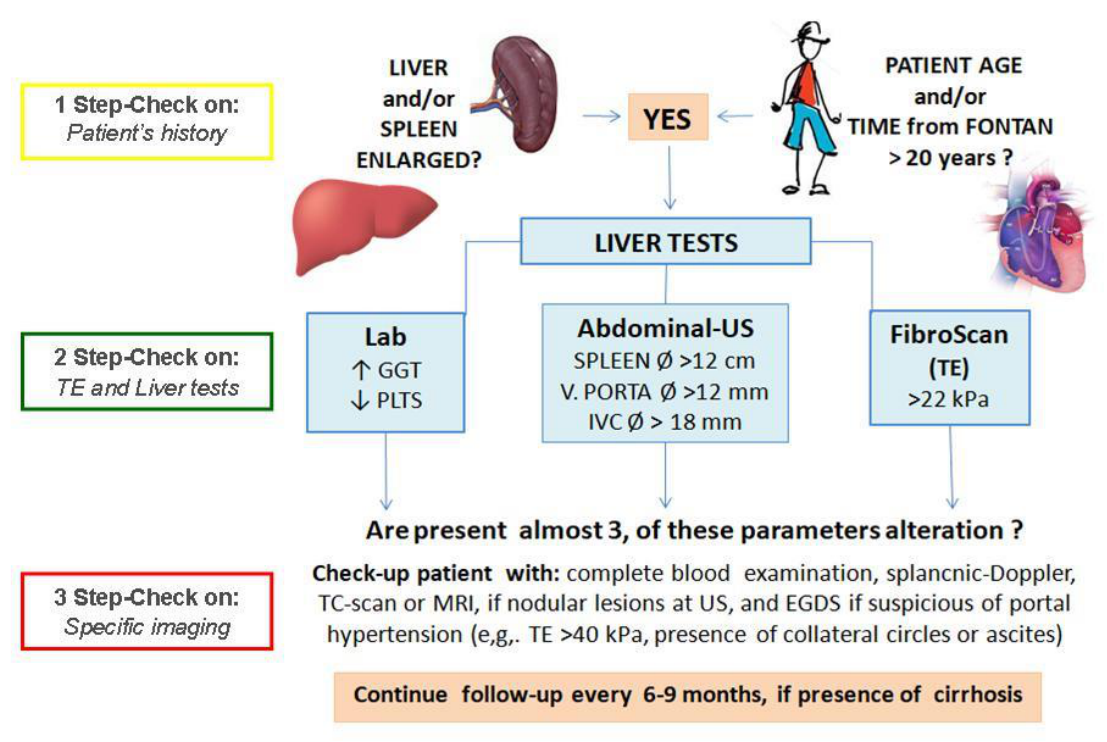
Figure 2. Step-by-step laboratory and instrumental approach to manage cases with signs or characteristics suggestive of Fontan-associated liver disease (FALD) in cases with single-ventricle (SV) and Fontan circuit.